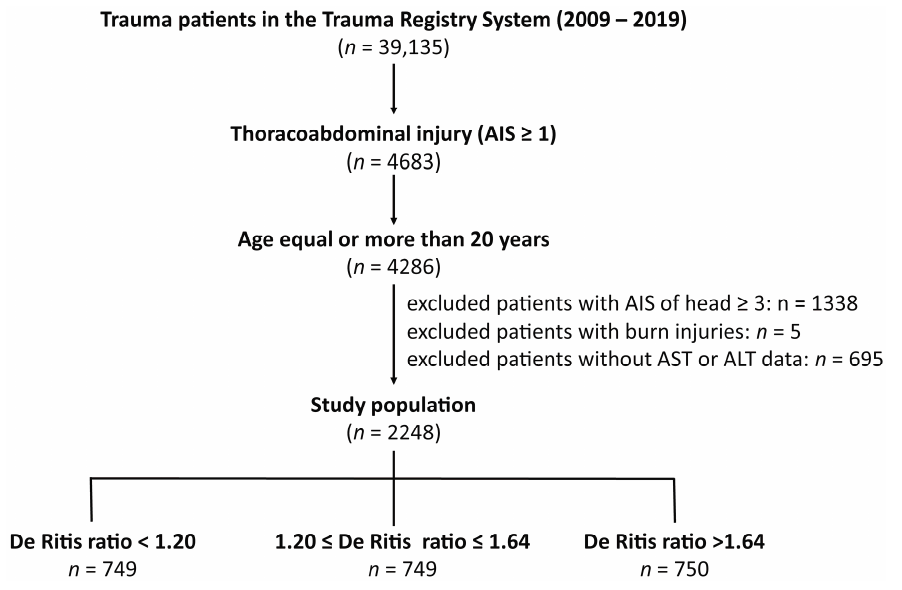
Figure 1. Flowchart illustrating the inclusion of hospitalized adult thoracoabdominal injury patients from the registered trauma database, with the assignment of the study patient populations into three groups according to the De Ritis ratio.